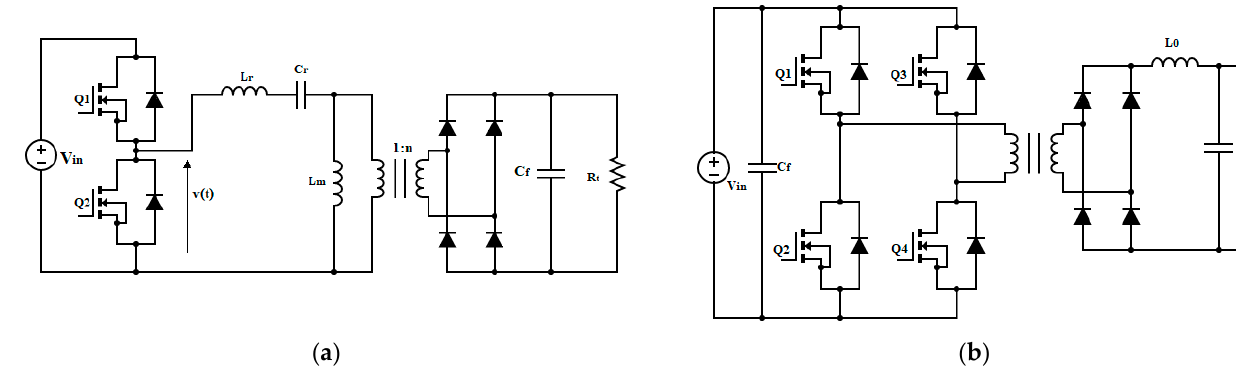
Figure 4. DC/DC converter topologies: ( a ) LLC resonant; ( b ) PSFB.